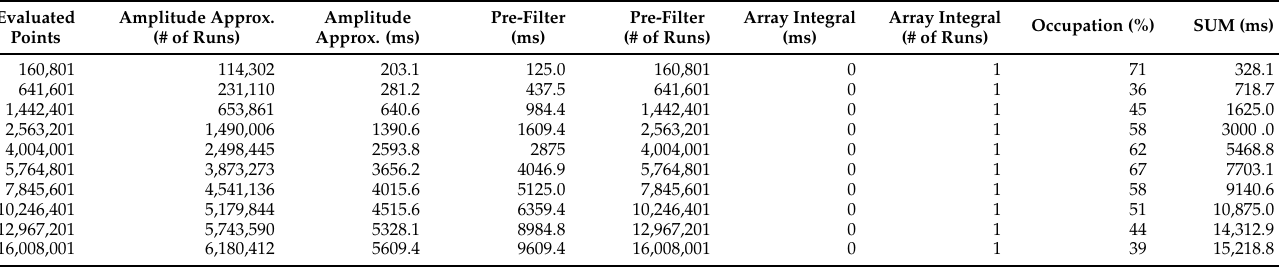
Table A6. Measurement results with pre-filtering with 1